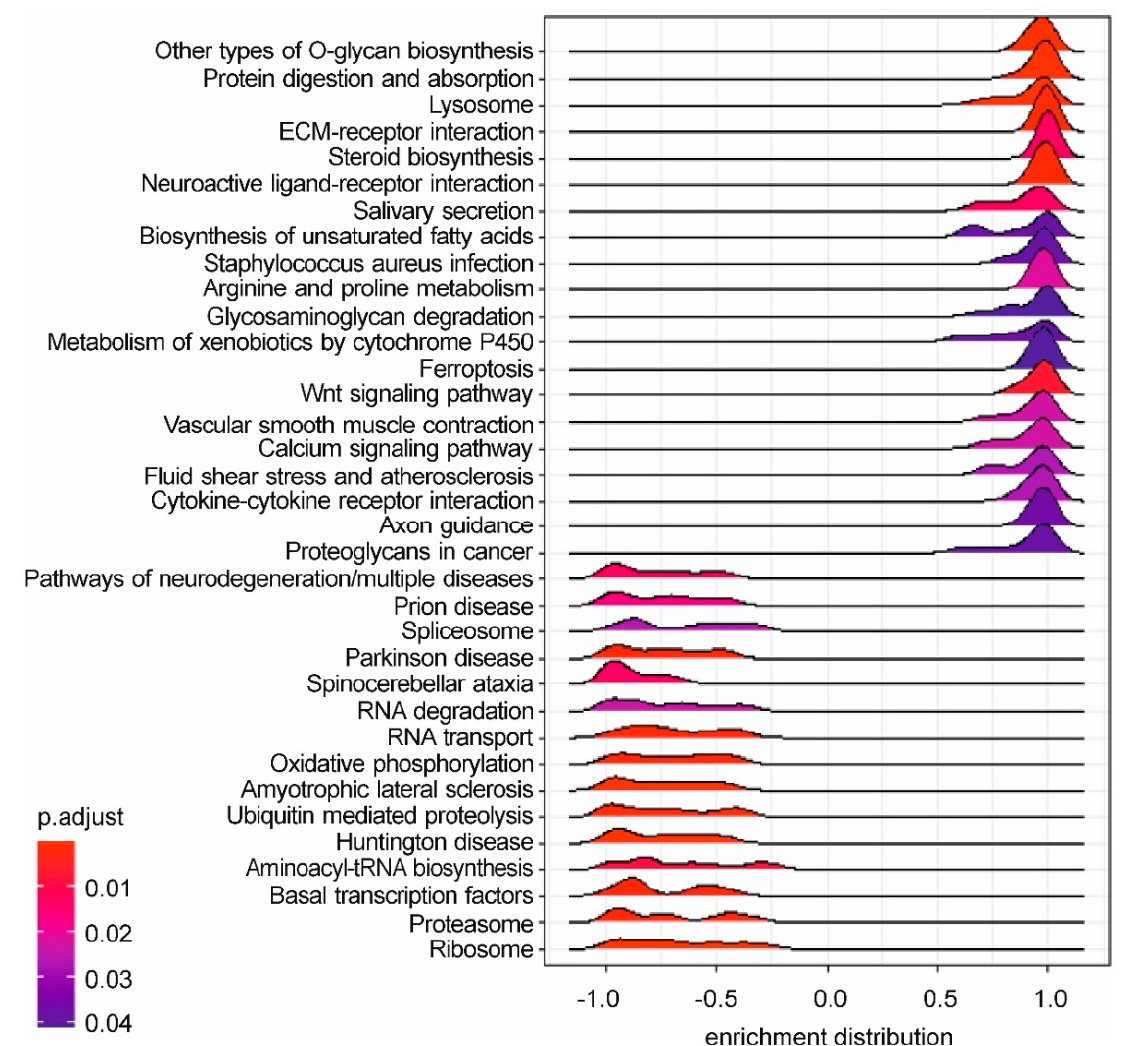
Figure 5. Gene Set Enrichment Analysis: R+AFB1 vs. AFB1. The ridgeplot visualizes the expression distributions of core enriched genes for GSEA enriched KEGG pathways. Gradient colour reflects the adjusted p -values (Benjamini–Hochberg method).